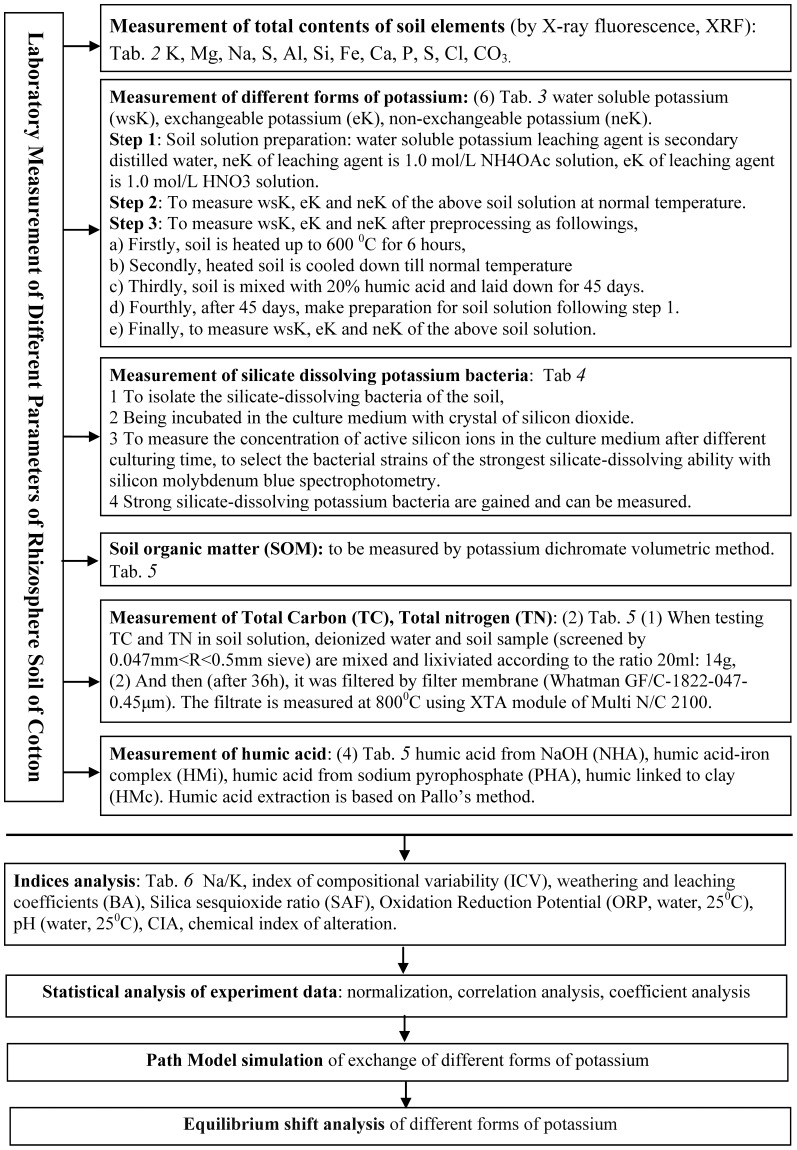
Workflow of evaluating status changes of soil potassium from Path Model.